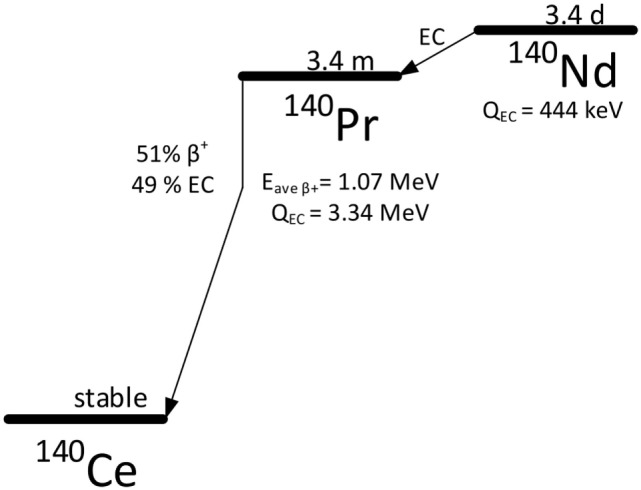
The decay scheme of 140Nd and its daughter 140Pr.